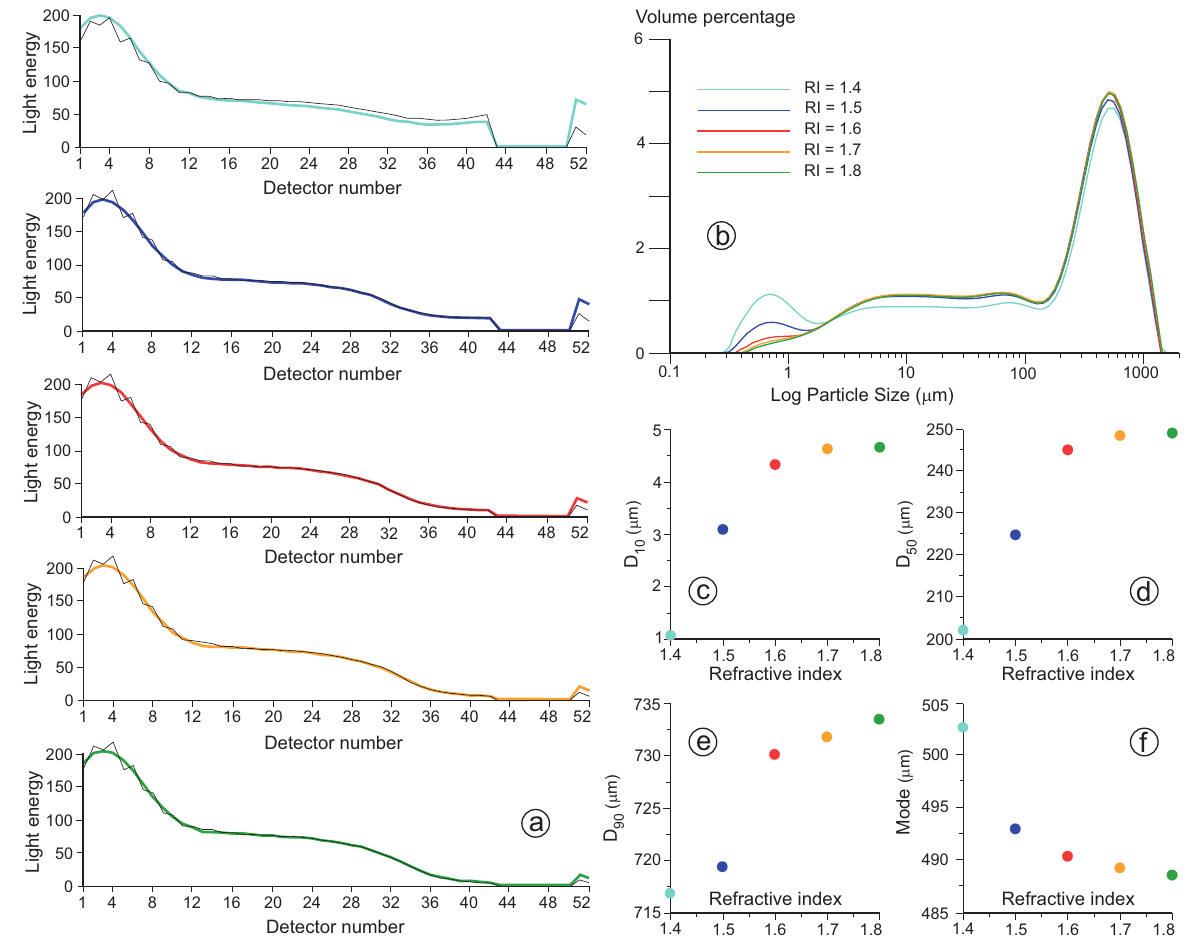
Fig. 22. Reprocessing of the first run data from test MP2000 5 on sub-sample aliquot CABRE3d (Fig. 9). (a) Light scattering data (black curve) and corresponding best fits for variable RI values of calcium carbonate from 1.4 to 1.8 (colour code in (b)), constant ABS values of calcium carbonate=0.1, and constant RI values of decalcified tap water=1.33. (b) Granulometric curves computed from reprocessed data in (a). (c) D 10 percentiles for data in the 5 curves illustrated in (b). (d) D 50 percentiles for data in the 5 curves illustrated in (b). (e) D 90 percentiles for data in the 5 curves illustrated in (b). (f) Modal values for data in the 5 curves illustrated in